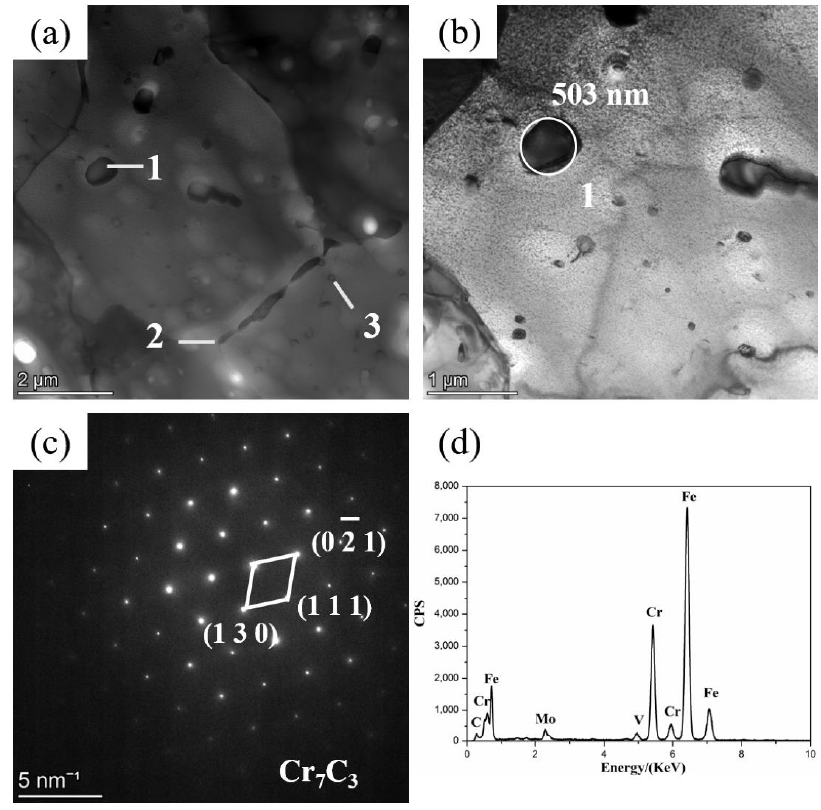
Figure 3. ( a ) TEM micrographs of carbides in RE-H13 die steel, ( b ) the morphology and ( c ) SAED patterns of intragranular carbides, ( d ) EDS analysis of Cr 7 C 3 precipitates after annealing.